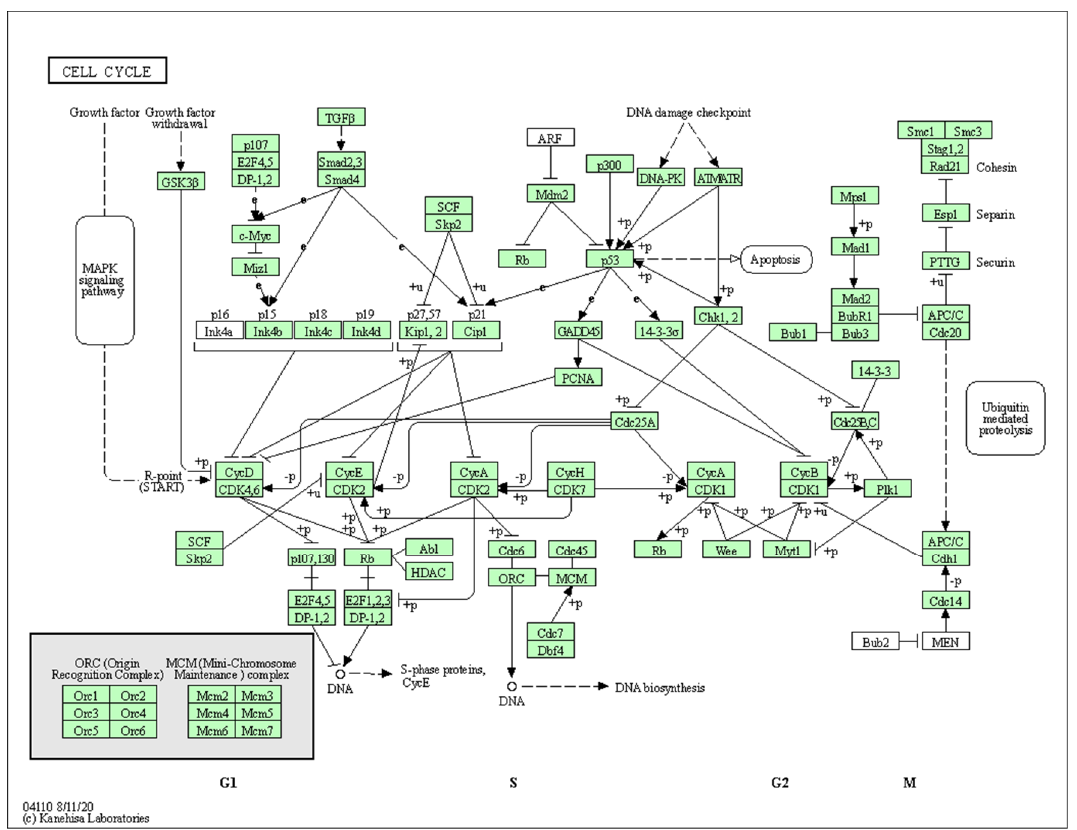
Figure A3. Cell cycle signaling pathway, KEGG pathway. KEGG, Kyoto Encyclopedia of Genes and Genomes. Copyright permission obtained.